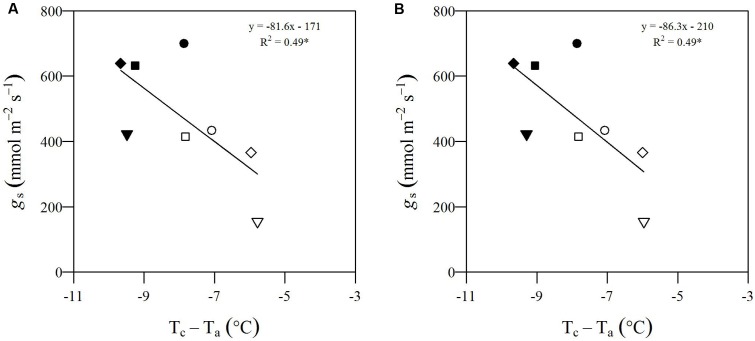
Relationship between gs (mmol m-2 s-1) and the difference between Tc and Ta (°C) for parental genotypes. (A) eCognition-based data and (B) Matlab-based data. For Poli (circle), 58-861 (triangle), P36 (square), and P64 (diamond), Tc and gs are obtained by averaging measurements taken on biological replicates. Both sets of data are fitted with a linear function (R2 = 0.49). Data relative to mDr conditions are displayed as white symbols, whereas WW data are shown as black symbols. During the UAV flights, Ta was equal to 28.75°C. Statistically significant (p-value ≤ 0.05) regressions are indicated with the symbol ∗.